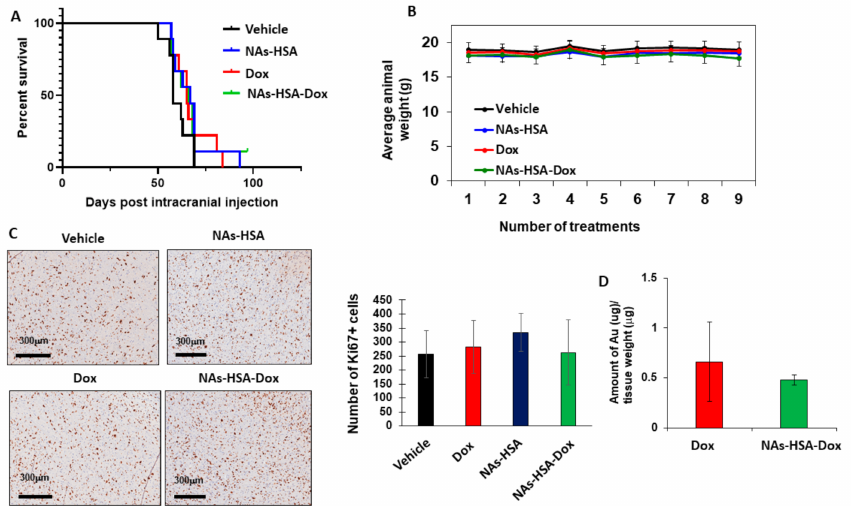
Figure 6. Therapeutic efficacy of gold nanoparticles (Au NP) loaded with Doxorubicin (Dox) in the HSJD-DIPG007 orthotopic animal model; ( A ) Survival curve of orthotopically-injected HSJD- DIPG007 into animals and subsequently treated with vehicle (0.9% Saline IV administration), NAs- HSA (50 mg/kg/day 3 days/week 3 weeks IV), Dox (1.35 mg/kg/day 3 days/week 3 weeks IV) and Nas-HSA loaded with Dox (equivalent to 1.35 mg/kg/day 3 days/week 3 weeks IV). Each treatment group consisted of 9 animals and tumour engraftment confirmed by neurological symptoms and/or weight loss. Therapeutic efficacy was not observed for any of the treatment cohorts (Vehicle vs. Dox p = 0.1421, Vehicle vs. Nas-HSA p = 0.1626, Vehicle vs. Nas-HSA-Dox p = 0.3932, Dox vs. Nas- HSA-Dox p = 0.9212); ( B ) Weight maintenance was similar among the four treatment cohorts for the duration of 9 doses (3 doses/week for 3 weeks); ( C ) Histologic analysis with Ki67 was performed on brains of two animals per cohort at the end of the treatments. Mostly, no differences were observed on Ki67 positive cells among the four treatments groups (Dox vs. Nas-HSA-Dox p = 0.188, Nas-HSA vs. Nas-HSA-Dox p = 0.321, Dox vs. Nas-HSA p = 0.420, Vehicle vs. Nas-HSA-Dox p = 0.113, Vehicle vs. Dox p = 0.063, Vehicle vs. Nas-HSA p = 0.032); Bar represents 300 µ m; ( D ) Low levels of gold were identified in tumour-bearing animals treated with Nas-HSA-Dox ( p = 0.368) 3 animals were used per treatment cohort at the end of the